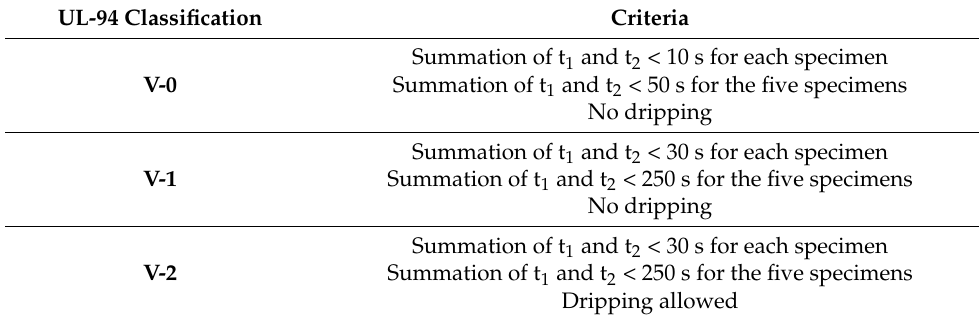
Table 2. UL-94 test criteria.